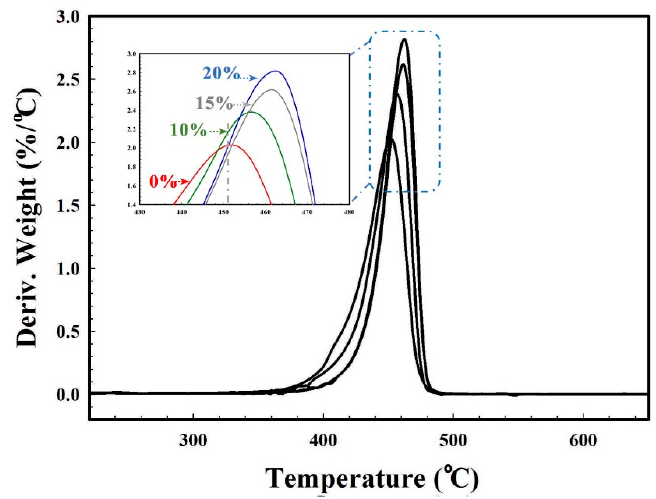
Figure 19. Derivative thermogravimetric analysis (DTGA) curves of MMFM samples compared to